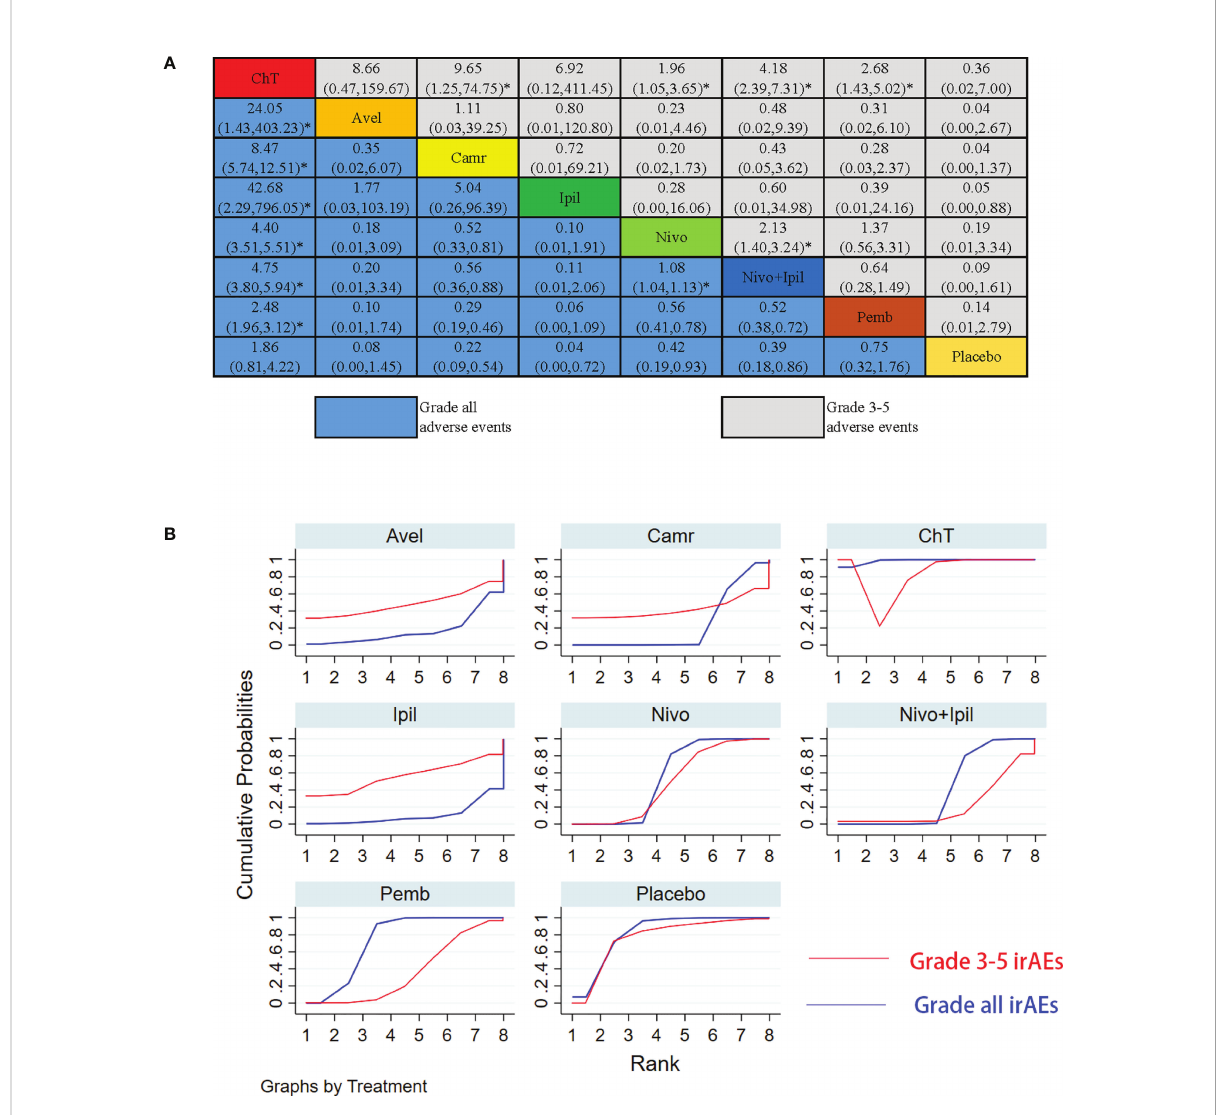
FIGURE 7 Results of the network meta-analysis for 10 treatment regimens in terms of immune-related adverse events (irAEs) with grade 3 – 5 irAEs and all- grade irAEs. (A) League table for different treatment regimens. (B) The surface under the cumulative ranking curves (SUCRAs) for grade 3 – 5 irAEs and all-grade irAEs. *: